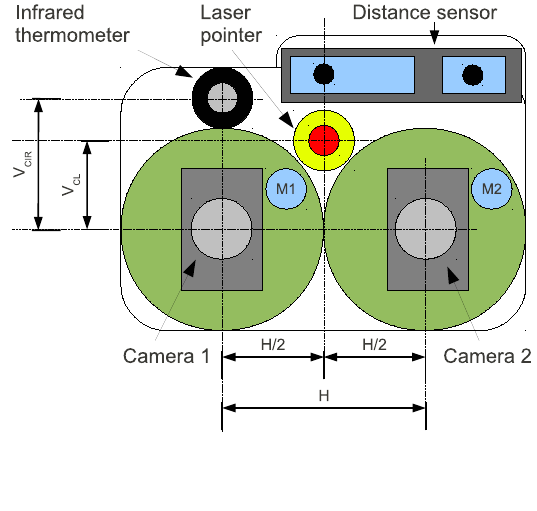
Figure 7. Optical sensors board scheme, and board